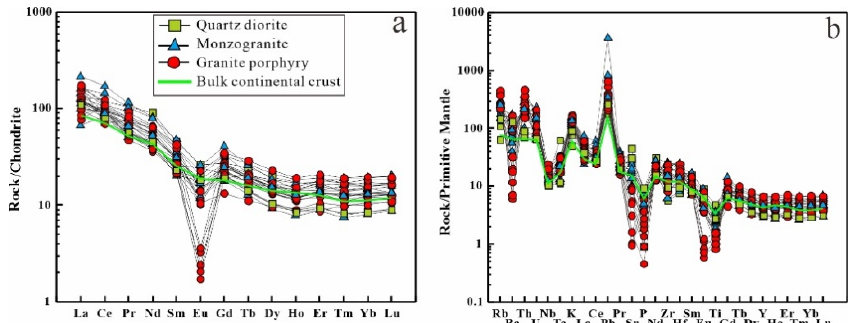
Figure 8. ( a ) Chondrite-normalized REE patterns and ( b ) primitive mantle normalized trace element patterns for the granitoids from Zalute. Chondrite and primitive mantle normalized values and composition of bulk continent crust can be found in Sun and McDonough [67].